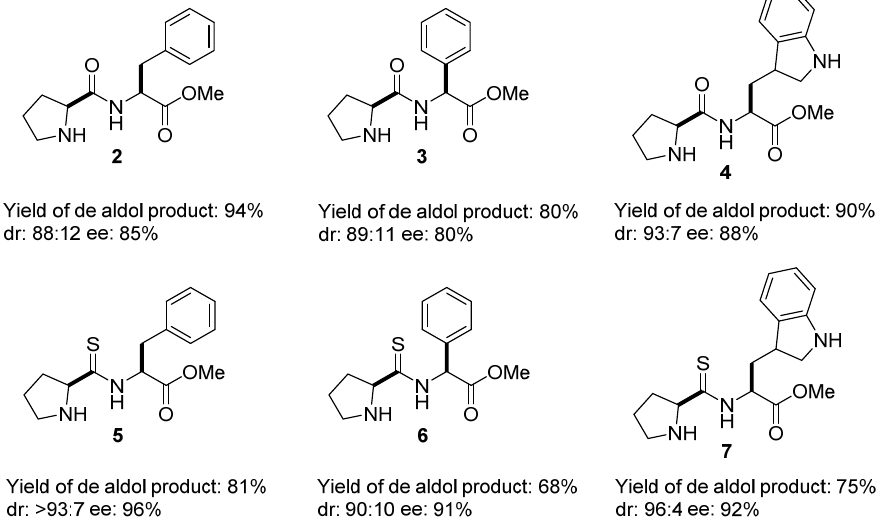
Figure 2. ( S )-Proline-containing dipeptides 2 – 7 used as organocatalysts for the asymmetric aldol reaction carried out under solvent-free HSBM conditions.